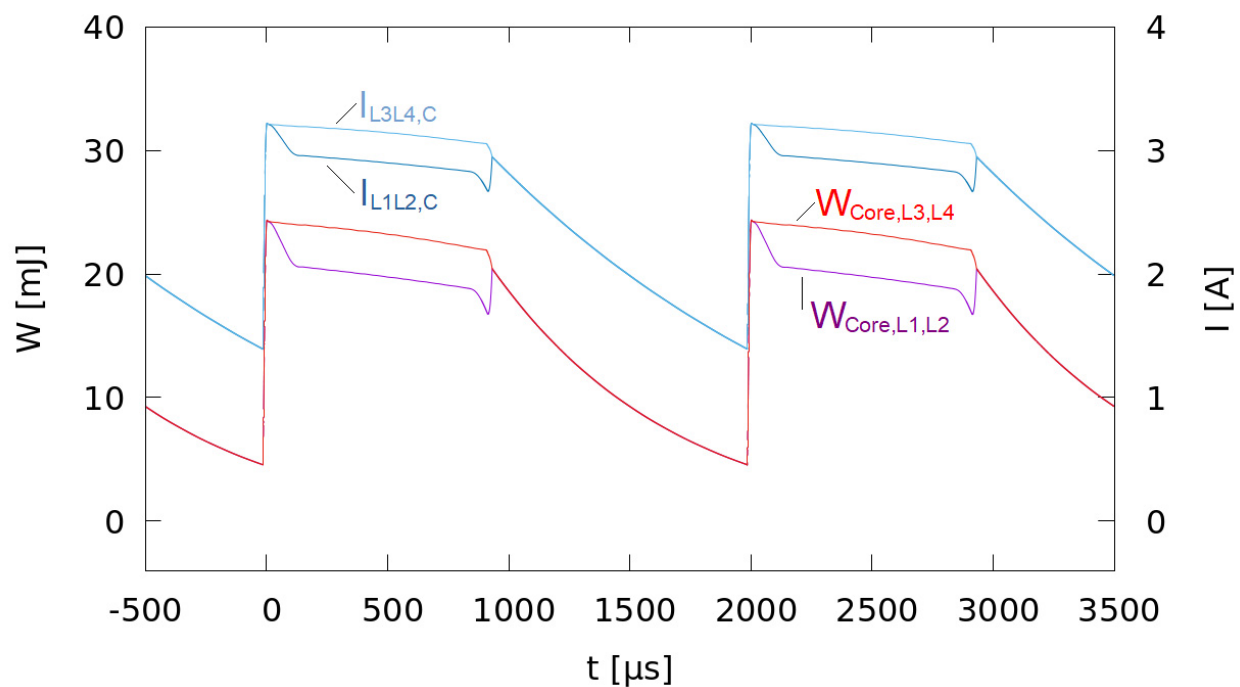
Figure 12. Energy stored in the cores of two current-compensated chokes (W Core ) and common-mode current I C through the chokes (Simulation for current-compensated chokes comprising L1, L2 and L3, L4 according to Figure 3, R D = 20 Ohm, on-time of the solid-state switches: t on = 22 µs).